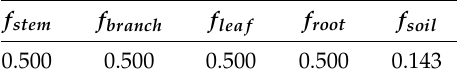
Table A18. Biomass carbon fraction parameters.